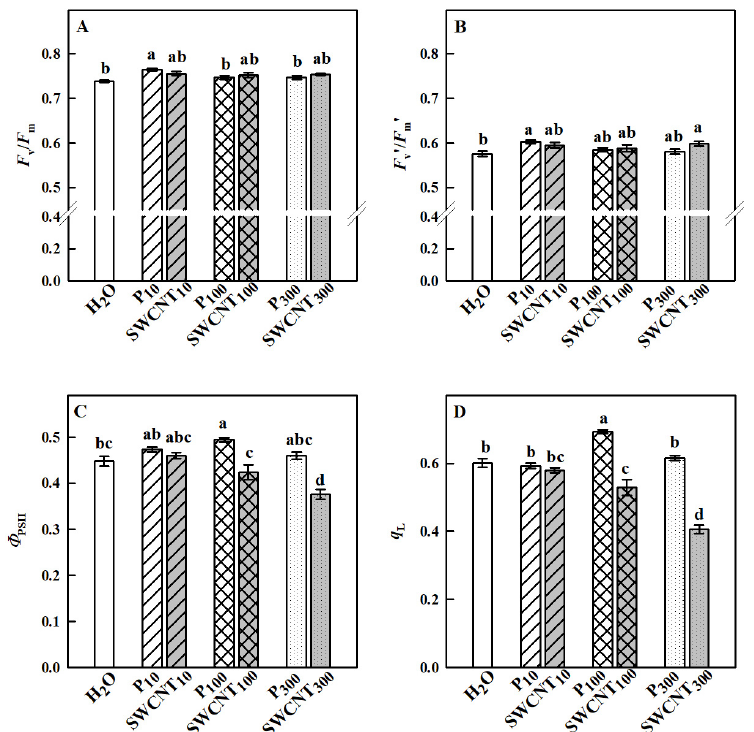
Figure 4. Effect of SWCNTs on chlorophyll fluorescence parameters. Maximum efficiency of PSII photochemistry in dark- ( F v / F m , A ) and light-adapted ( F v ʹ / F m ʹ , B ) leaves, actual photochemical efficiency of PSII ( Φ PSII , C ) and fraction of open PSII centers ( q L , D ) of pea plants seven days after spraying with different concentrations of “Pluronic” P-85 (P) and SWCNTs. Plants sprayed with H 2 O served as the control. Data are means ± SE ( n = 6). One-way analysis of variance (ANOVA) with a between-subjects factor was performed to assess statistically significant mean differences. Mean separation was performed using a Tukey’s test and statistically different means at the 5% level ( p < 0.05) are indicated with different letters.